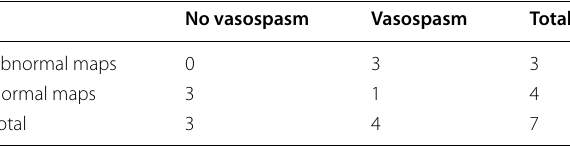
Only MTT and TTP maps in the CTP measurements showed abnormal measurements in the patients who developed vasospasm ( p exact test, n =